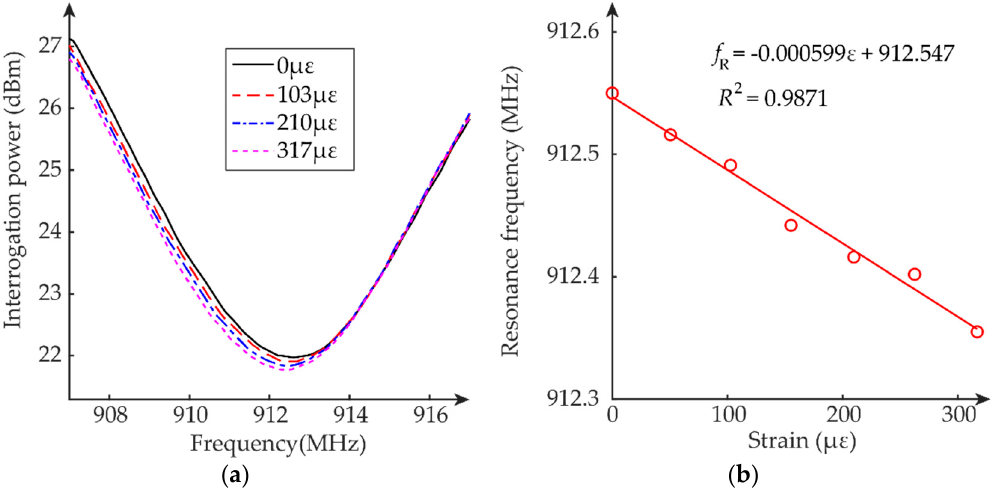
Figure 10. Tensile test results of passive mode test: ( a ) average interrogation power threshold, ( b ) resonance frequency f R versus strain ε .